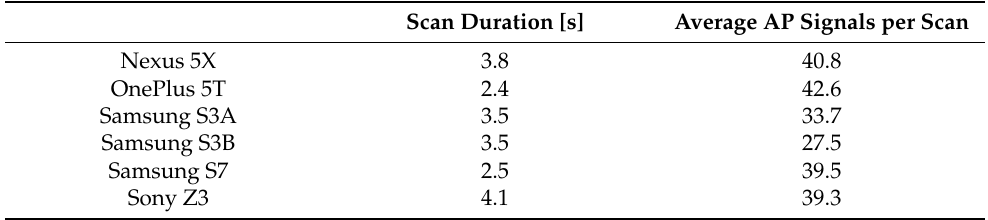
Figure 4. Examples of a stop-and-go measurement run for the two smartphones ( top ) OnePlus 5T and ( bottom ) Sony Z3 which measured simultaneously.